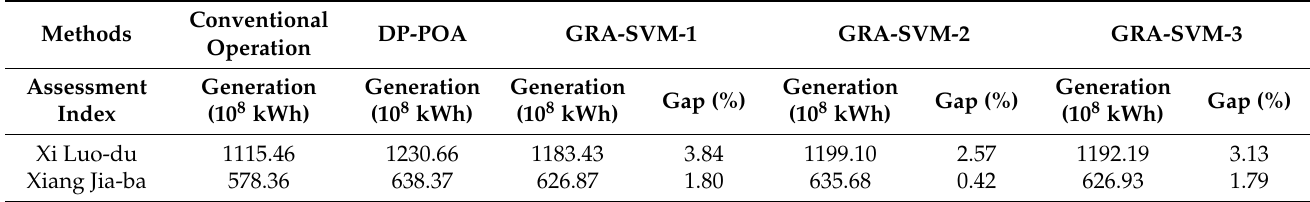
Figure 5. Comparison between deterministic optimization and three GRA-SVM schemes. Table 4. Comparison of operation results in different